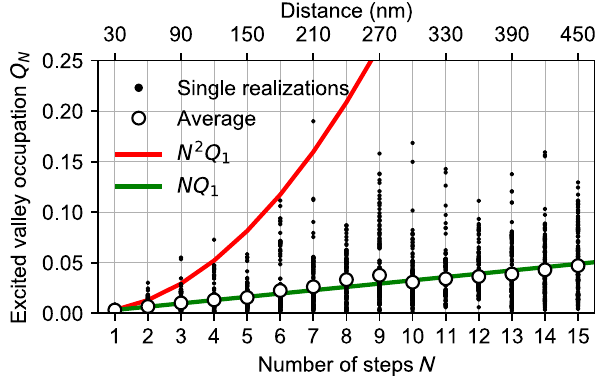
FIG. 19. Probability of occupying higher valley state after N - step passage Q N . We use a simple model of disorder in which electron velocity v fluctuates between the realizations (filled dots) with rms δv = 0.1 v , and for remaining parameters we take L = 15 nm, E VS,0 = 100 µ eV, v = 30 m/s, ϑ = 0.25 ◦ , which corresponds to d ∼ 30 nm. To show statistical behavior, for each number of steps N we draw a new arrangement of steps with terrace lengths given by the distribution Eq. (D10) and for that arrangement simulate 200 realizations of